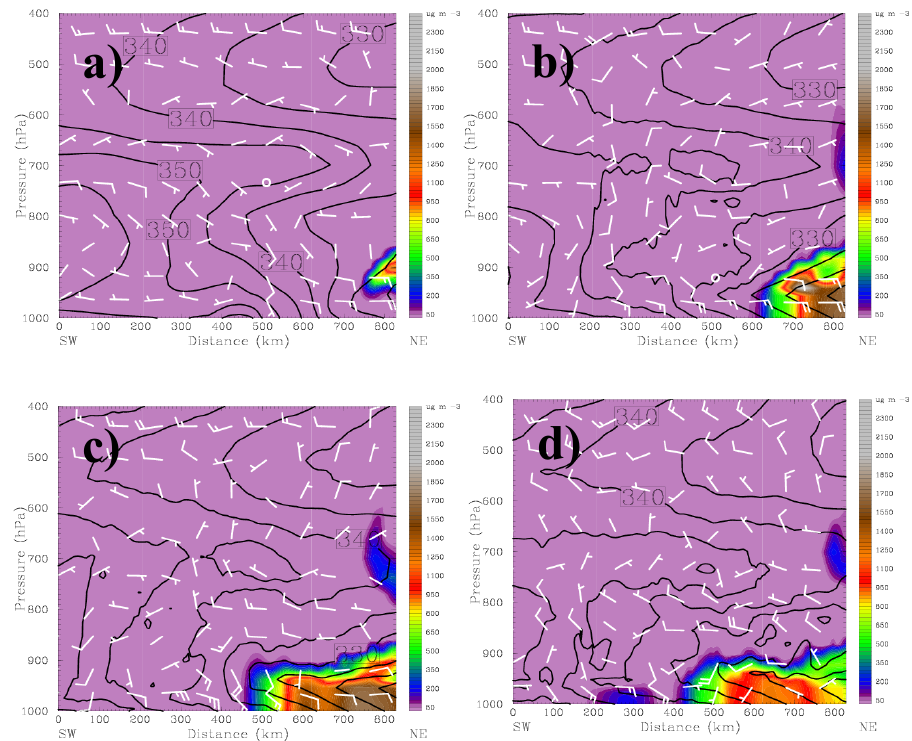
Fig. 11. The cross-section distribution of wind field, theta-e (contour) and PM 10 concentration (colored) along NE2 in Fig. 9 at (a) 18:00UTC, 20 March (b) 00:00UTC, 21 March (c) 06:00UTC, 21 March (d) 12:00UTC, 21 March. A full (half) wind barb indicates 5ms − 1 (2.5ms − 1